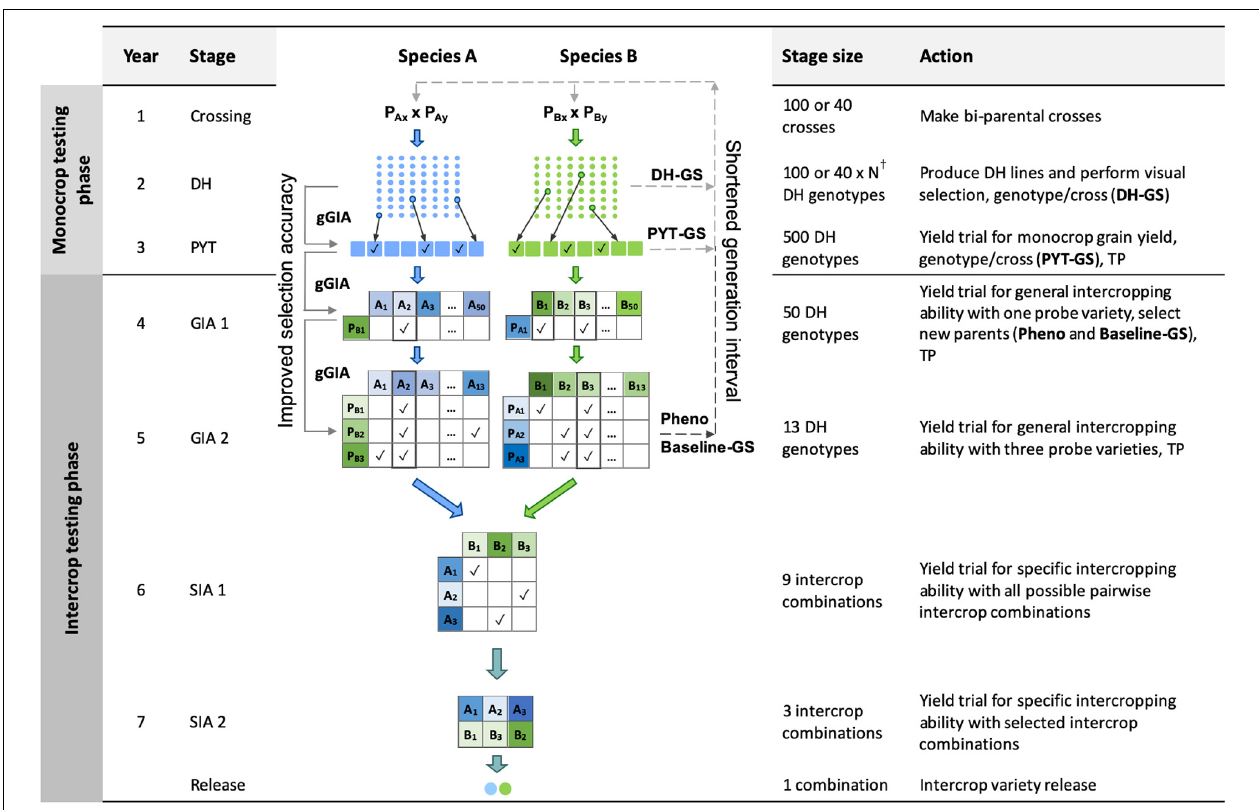
FIGURE 1 | Schematic overview of the Phenotypic selection breeding program (Pheno) and the three Conventional genomic selection breeding programs. Baseline-GS, the Baseline genomic selection breeding program; PYT-GS, the Preliminary yield trial genomic selection breeding program; DH-GS, the Doubled haploid genomic selection breeding program; gGIA, genomic-predicted general intercropping ability; TP, denotes stages in which genotypic and/or phenotypic records are collected; DH, the doubled haploid stage; PYT, the preliminary yield trial stage; GIA 1 and 2, the general intercropping ability stages 1 and 2; SIA 1 and 2, the specific intercropping ability stages 1 and 2. Solid line with arrow represents increased selection accuracy based on gGIAs and dashed line with arrow represents shortened generation interval. † The number of DH lines per cross (N) differs for each breeding program to maintain equal operating